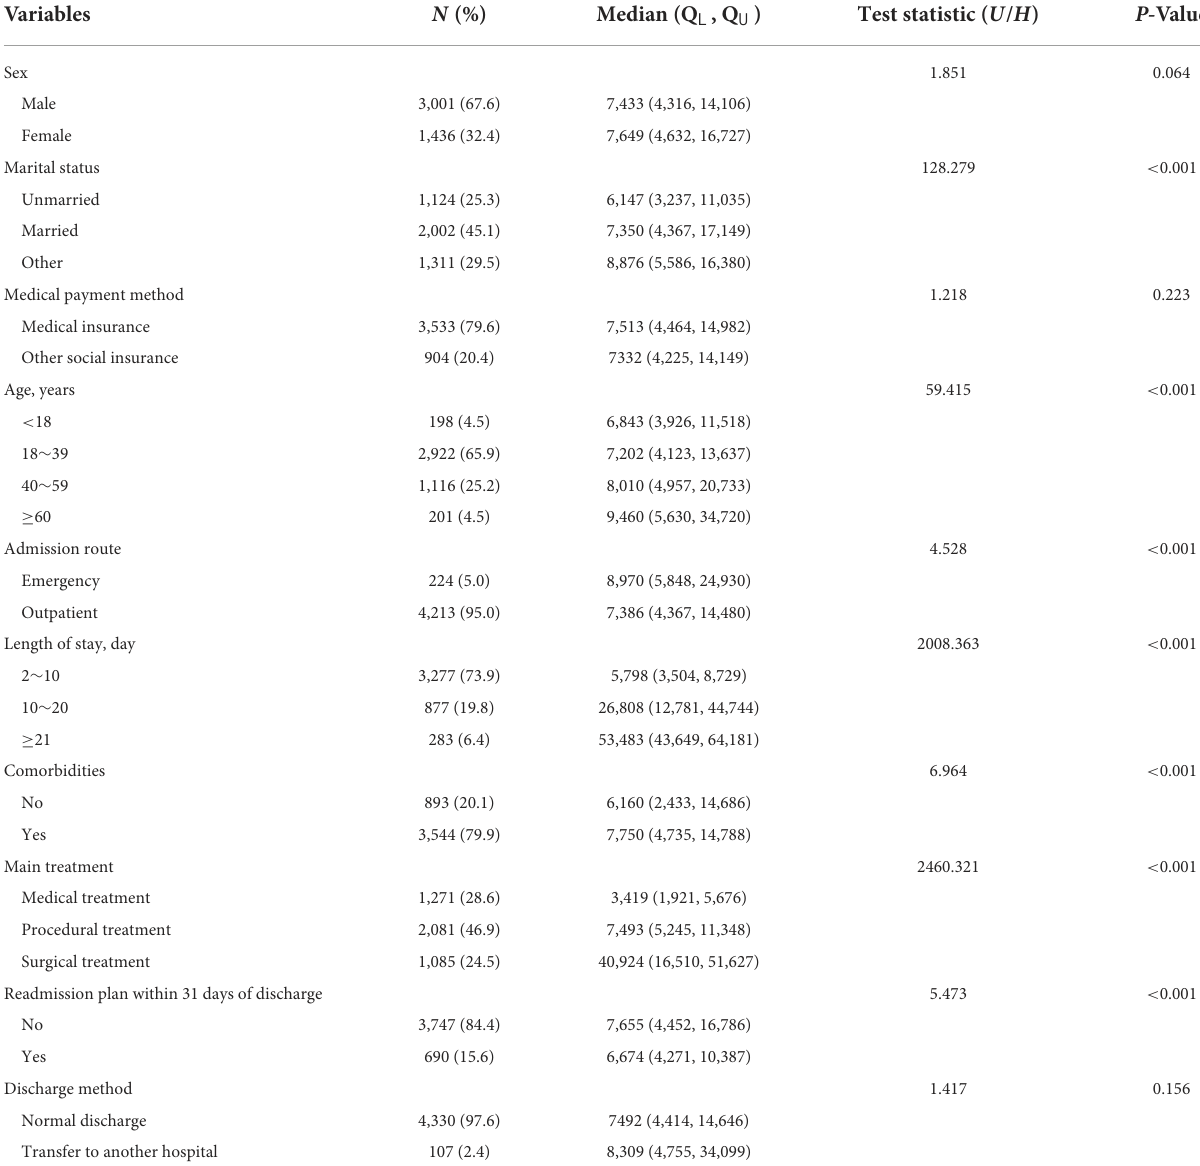
TABLE 1 Baseline characteristics and difference in hospitalization expenses of Crohn’s disease ( N =